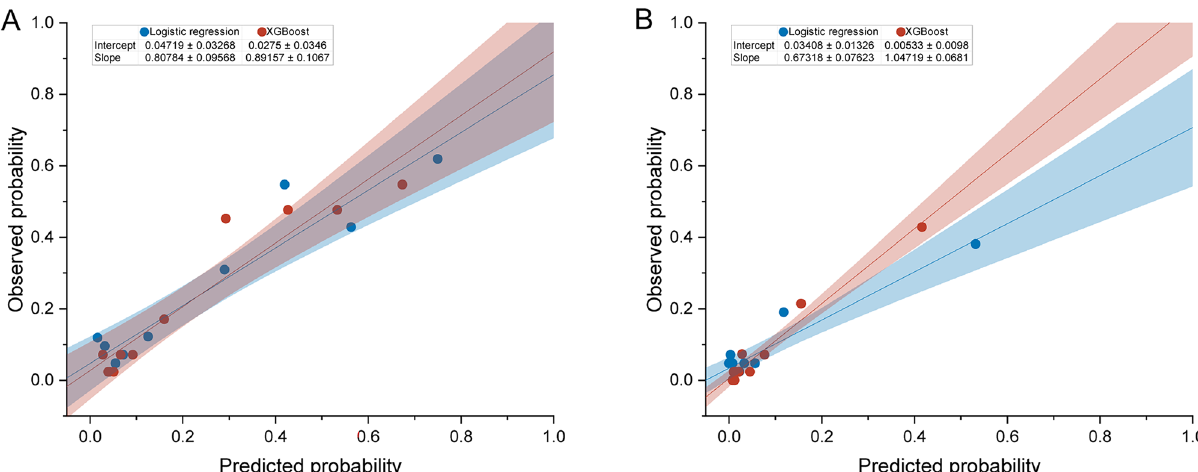
Figure 4. Calibration curves of the logistic regression and XGBoost models for MAKE30 ( A ) and 90-day adverse outcomes ( B ) in the test set. The Brier scores of the null model, logistic regression model, and XGBoost model for MAKE30 were 0.239, 0.144, and 0.141, respectively. The Brier scores of the null model, logistic regression model, and XGBoost model for 90-day adverse outcomes were 0.088, 0.074, and 0.065,